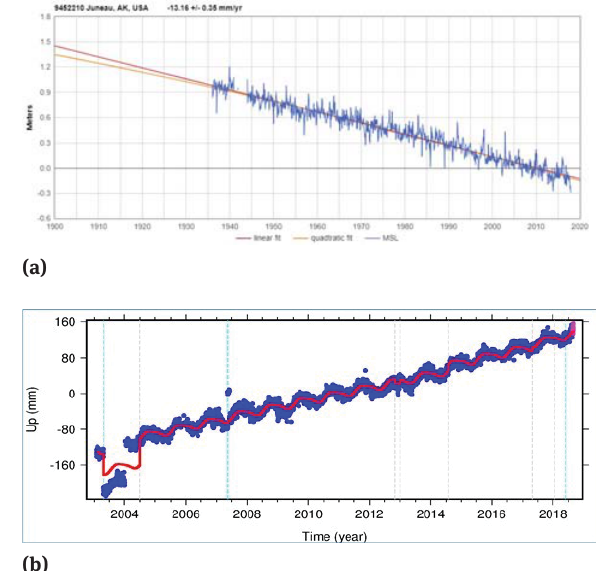
Figure 4: (a) MSL data for Sitka, AK, USA. Image reproduced mod- ified after [4]. (b) GNSS time series for BIS6. Image reproduced modified after NGL.